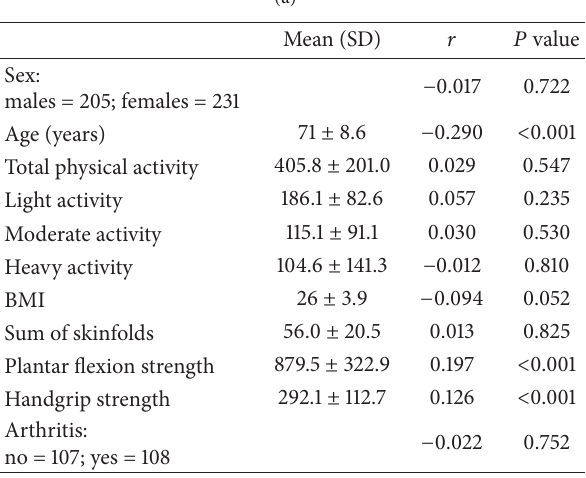
Table 2: (a) Univariate associations with shoulder flexibility. (b) Univariate associations with hip flexibility.